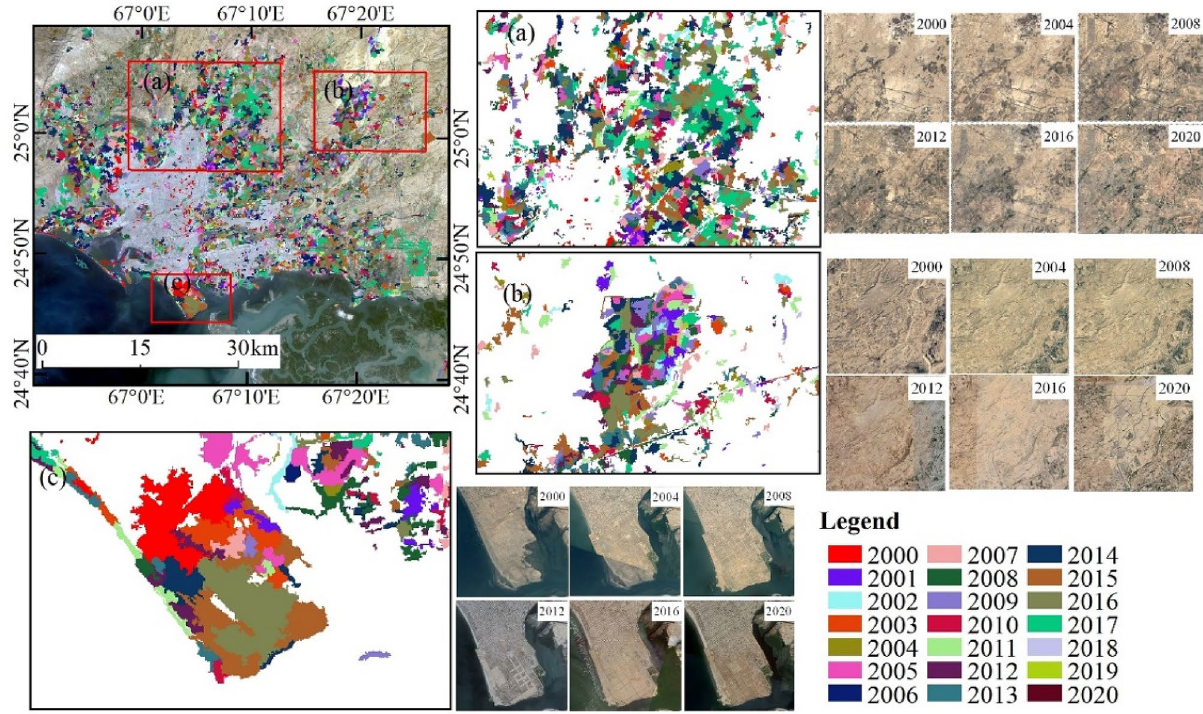
Figure 5. Map of the spatial distribution of new urban expansion areas in Karachi, 2000–2020. (a) Newly constructed residence estates in the north, (b) newly built theme park and residences in Bahria Town, Karachi, (c) newly built residential area to reclaim the sea. (The map created in ESRI ArcMap 10.2, https:// suppo rt. esri. com/ zh- cn/ produ cts/ deskt op/ arcgis- deskt op/ arcmap/ 10-2-2). Image data source in the upper left: Landsat OLI image (2020) from USGS (United States Geological Survey). Time series images (2000, 2004, 2008, 2012, 2016, and 2020 were obtained from Google Earth Pro 7.3.4 (https:// www. google. com/ earth/ versi ons/# earth-